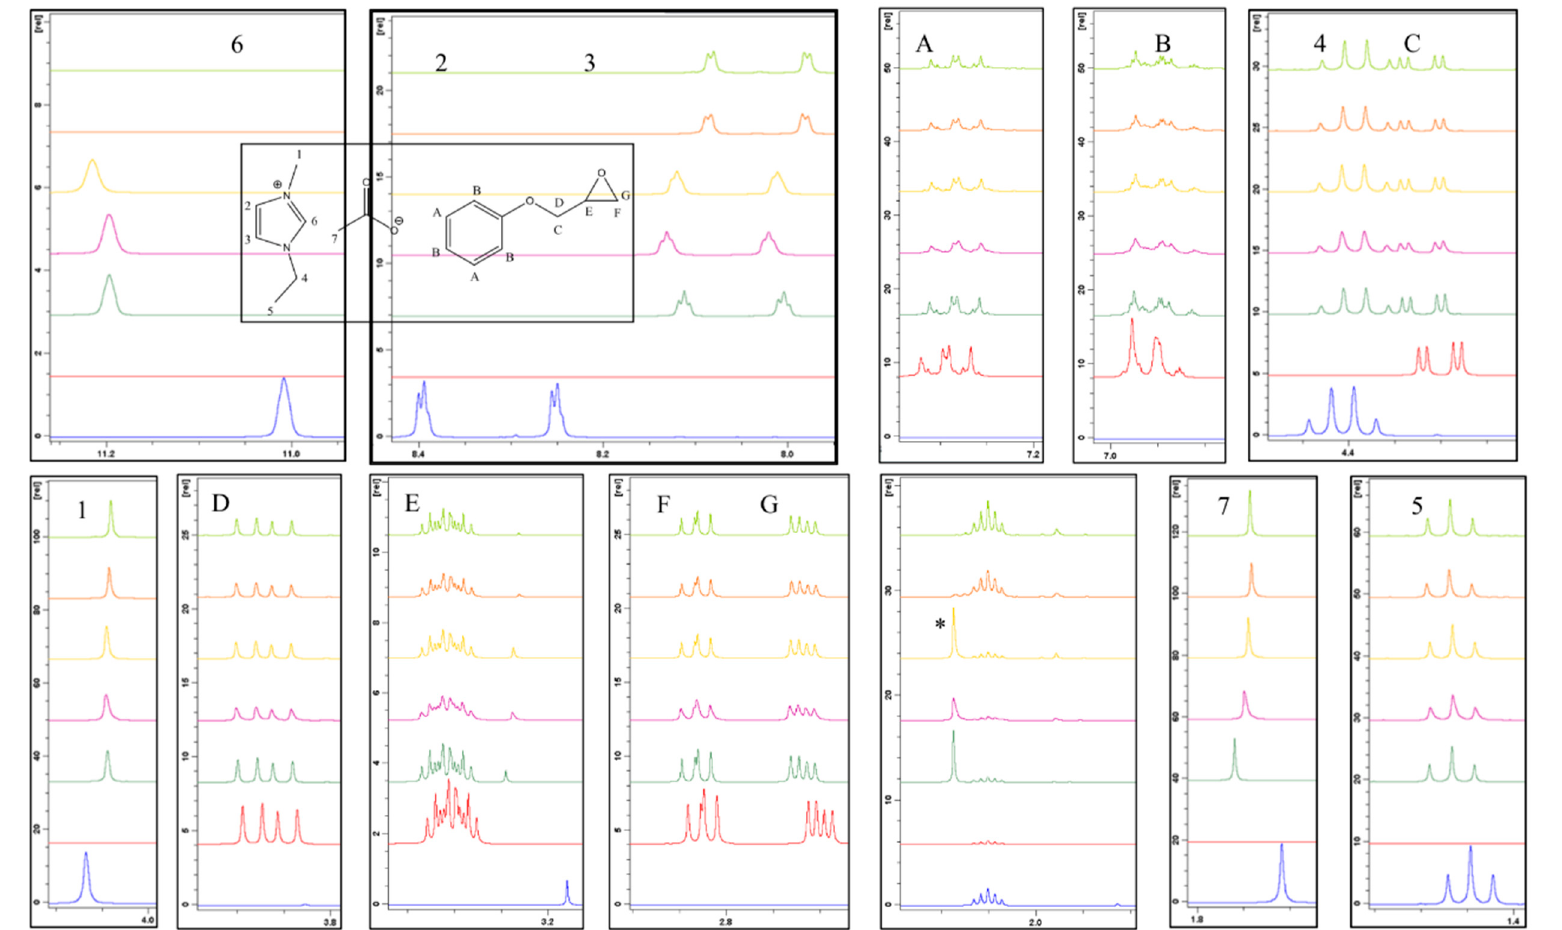
Figure 6. Expanded overlaid 1 H NMR spectra of a room-temperature-stored 1:1 formulation of PGE and 1-ethyl-3-methylimidazolium acetate.